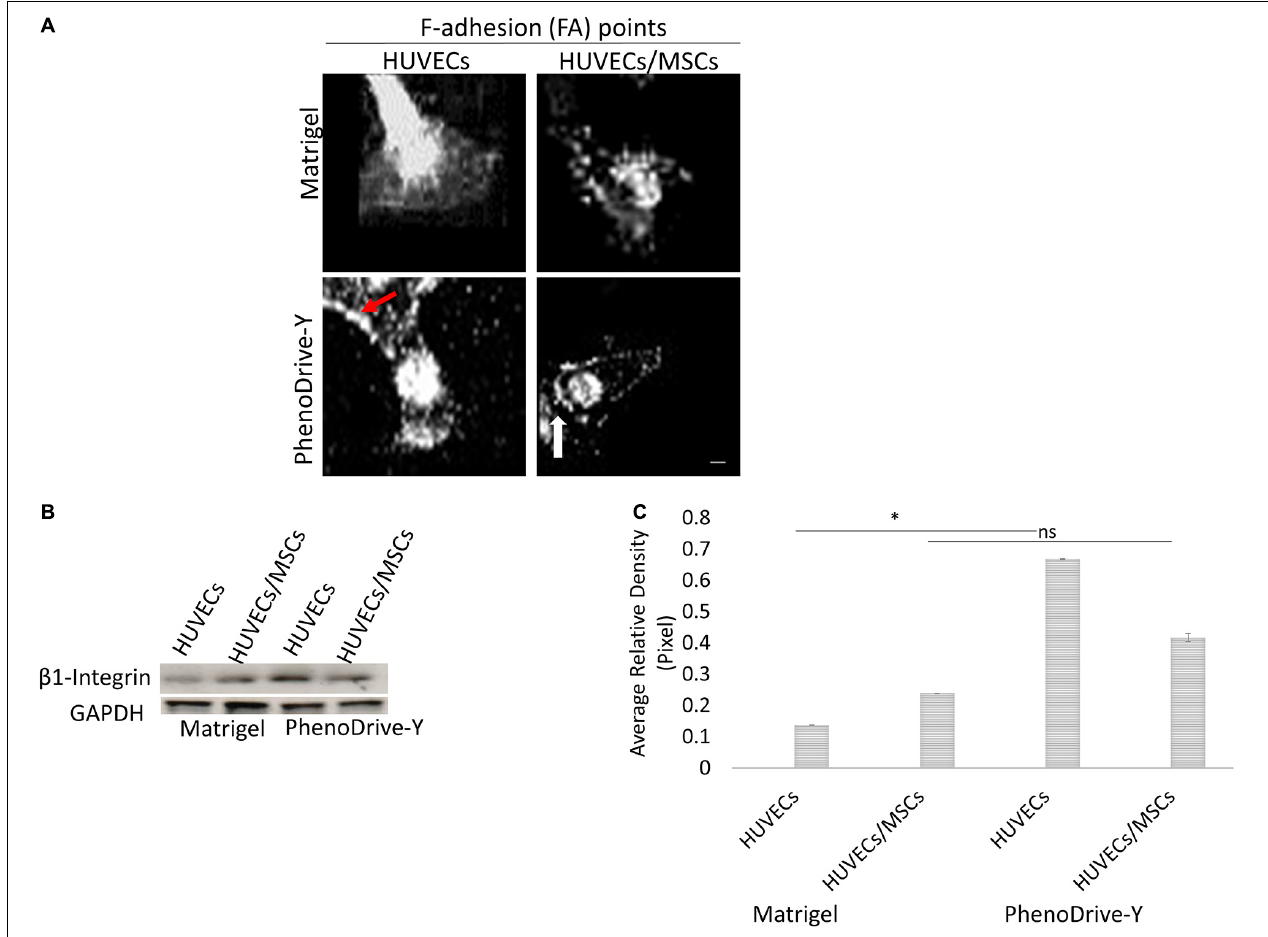
FIGURE 4 | Cytoskeleton formation in monoculture and co-cultured human umbilical vascular endothelial cells (HUVECs) after 48 h incubation. (A) Distribution of F-adhesion (FA) points at the HUVEC leading edge ( red arrows , cluster of focal points; white arrow , actin bundles). Scale bar , 25 µ m. (B) Western blot and (C) quantification by densitometry of levels of β 1 integrin regulation normalized to GAPDH ( n = 6). * p < 0.01, ns not significant difference.